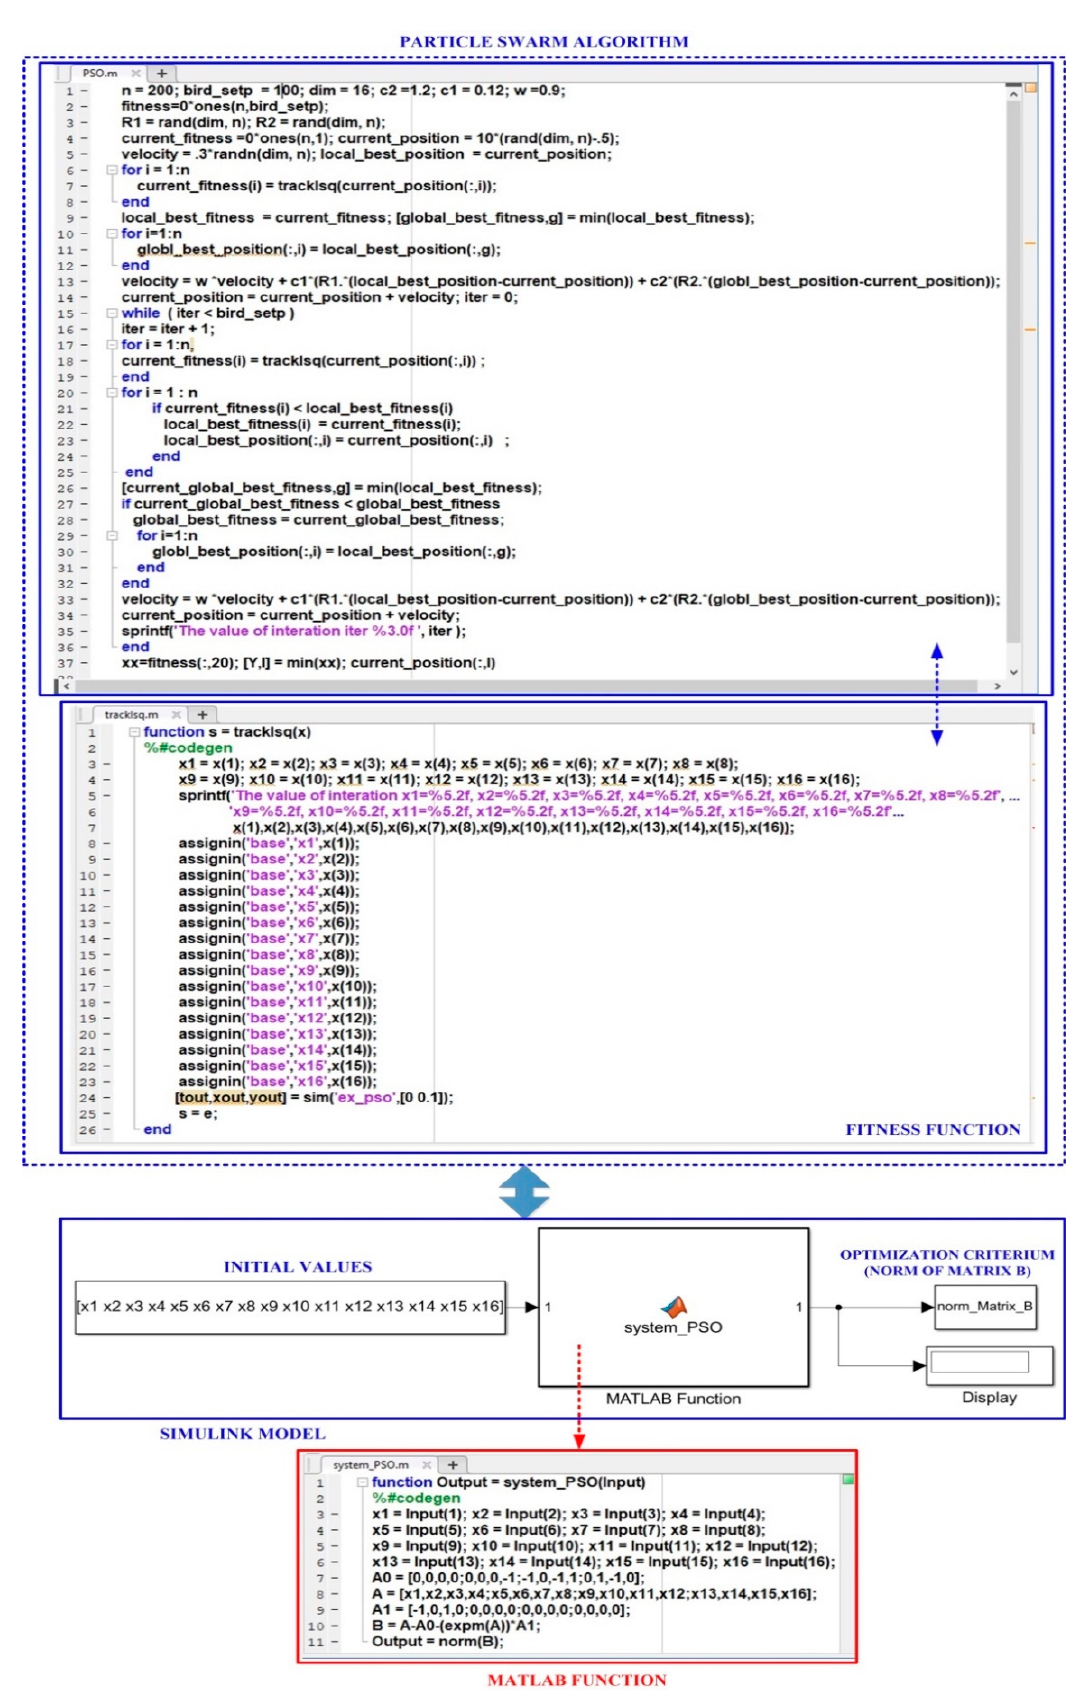
Figure A2. Implementation of the PSO algorithm in MATLAB/Simulink for transcendental matrix equation with dimension ≥ 2.